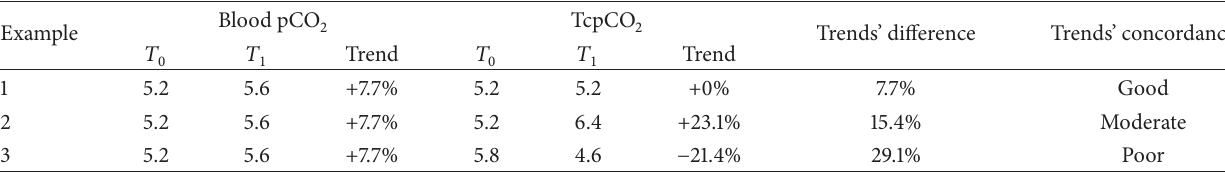
Trends’ difference Trends’ concordance